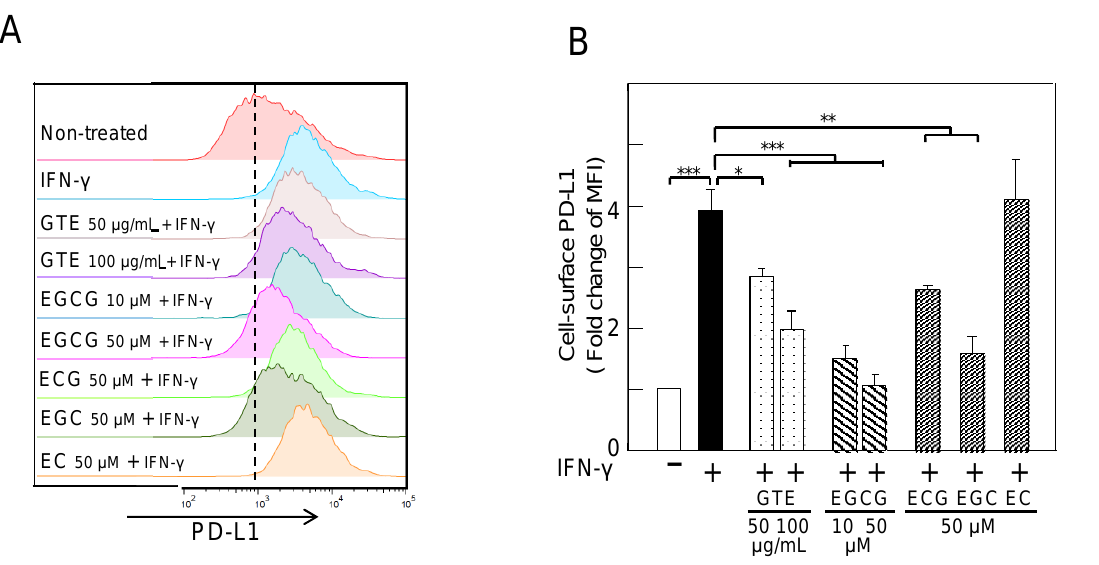
Figure 1. Inhibition of interferon (IFN)-γ–induced cell-surface programmed cell death ligand 1 (PD-L1) protein by green tea extract (GTE) and green tea catechins in A549 cells. (A ) Cell-surface PD-L1, and ( B ) average of fold change of median fluorescence intensity (MFI). “−“ and “+” indicate in the absence or presence of IFN-γ (10 ng/mL). * p < 0.05, ** p < 0.01, *** p < 0.001. EGCG, (−)-epigallocatechin gallate; ECG, (−)-epicatechin gallate; EGC, (−)-epigallocatechin; EC, (−)-epicatechin.